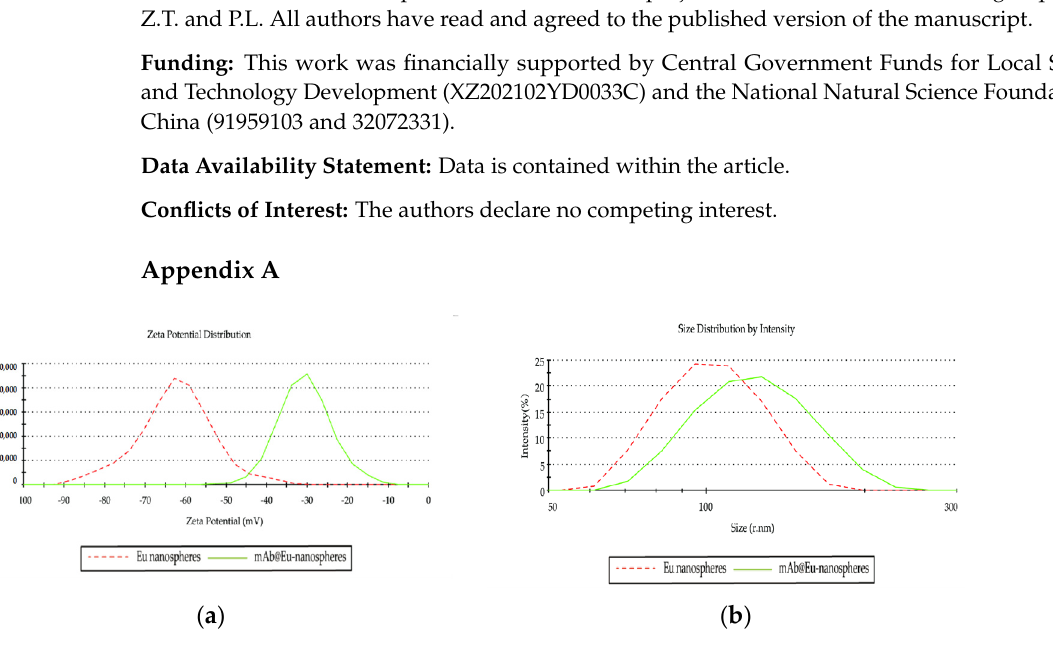
Figure A1. ( a ) zeta potential distribution of Eu-nanospheres and mAb@Eu-nanospheres. ( b ) size distribution by intensity of Eu-nanospheres and